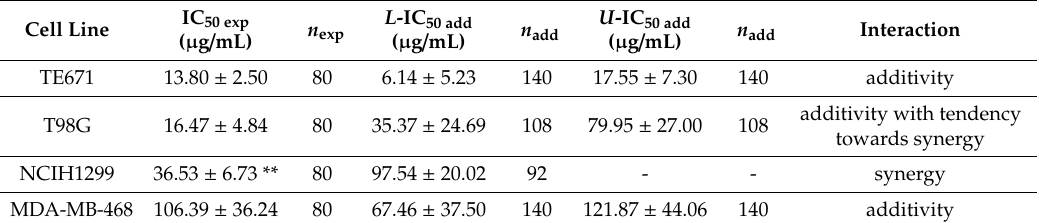
Table 2. Type I isobolographic analysis of interactions (for nonparallel and parallel